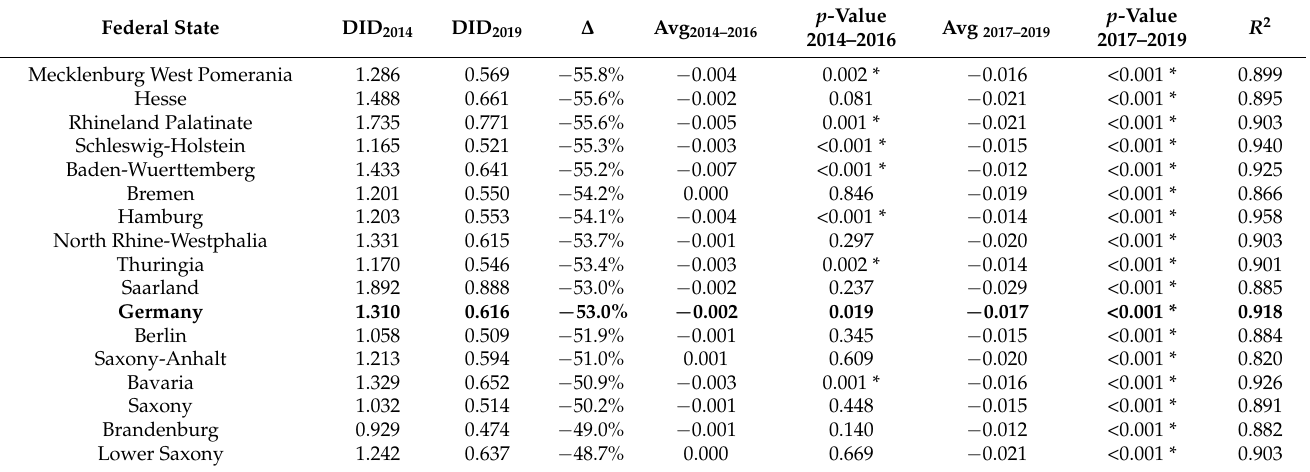
Table 4. Trends for fluoroquinolone DID during 2014–2019. Abbreviations: DID 2014 , Average DID in 2014; DID 2019 , Average DID in 2019; ∆ , percentage difference between 2019 and 2014 values; Avg, average monthly change in DID. In order to account for the different alpha levels for the individual federal states due to the Bonferroni-Holm method, Avg that are significantly different from zero are marked with *; R 2 , coefficient of determination for the applied